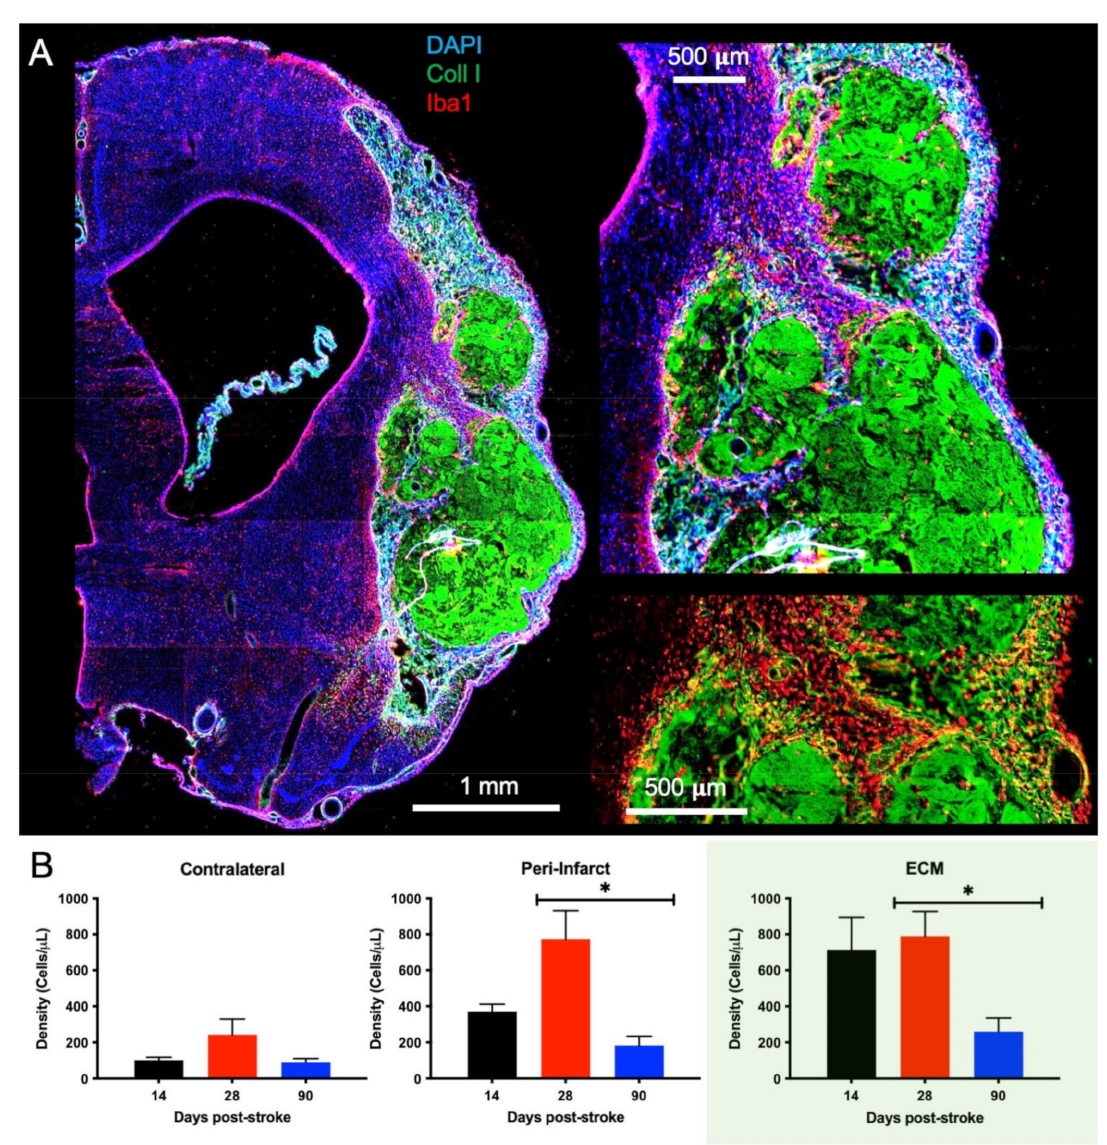
Figure 5. Macrophage Invasion. ( A ) A whole hemisphere image reveals the accumulation of Iba1+ cells around the implanted ECM hydrogel (collagen I+). A magnified view of the area between the cortex and striatum further highlights the invasion of Iba-1+ macrophage is evident at the tissue/hydrogel interface (90-days post-stroke implant). Visualization of only the Iba-1+ cells and the ECM hydrogel (bottom right image) accentuates the dense accumulation of macrophages in tissue before infiltrating the bioscaffold. ( B ) Quantification of the Iba-1+ cells revealed a much larger density of macrophages within and surrounding the ECM compared to the contralateral hemisphere. The 90-days post-stroke implantation also showed the least macrophage infiltration compared to the 14- and 28-days time points (* p < 0.05), with <500 cells/ µ L within the